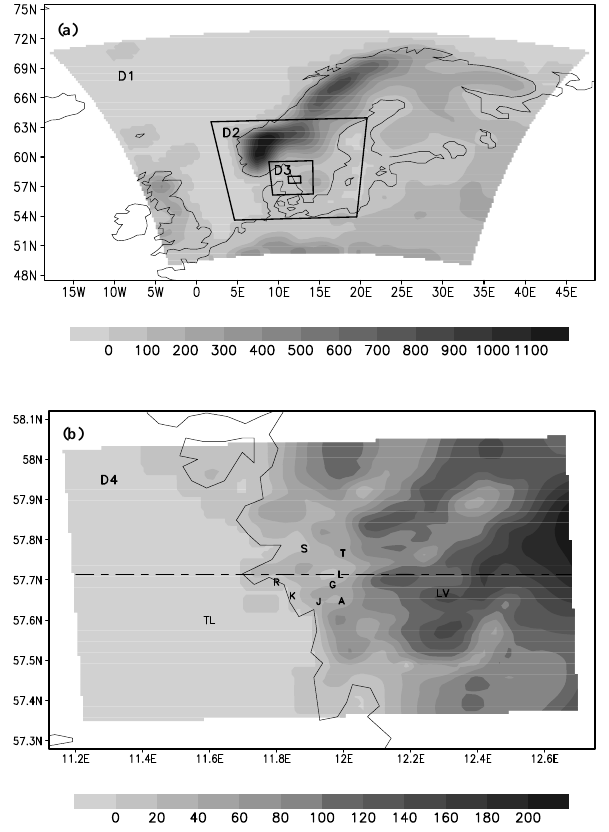
Fig. 1. (a) Modelling domains and grid configuration. Domains 1, 2, 3, and 4 (denoted by D1, D2, D3 and D4) have a horizontal grid resolution of 54, 18, 6 and 2km, respectively. Four domains consist of 50 × 50, 64 × 55, 62 × 52, and 40 × 46 horizontal gridcells (N-S direction by E-W direction), respectively. Innermost domain refers to D4. Shaded is model terrain (in meters) with 54-km grid resolution for D1; (b) Zooming-in model area of interest (D4) and model terrain (shaded in meters) with 2-km grid resolution, as well as locations of observational sites by letters: K (Kanotf¨oreningen), R (Risholmen), J (J¨arnbrott), A ( ˚Aby), G (GVC), L (Lejonet), T (Tagene), S (S¨ave), TL (Trubaduren), and LV (Landvetter). Dashed line indicates location of the vertical cross-section used in this study (along 57.72 ◦